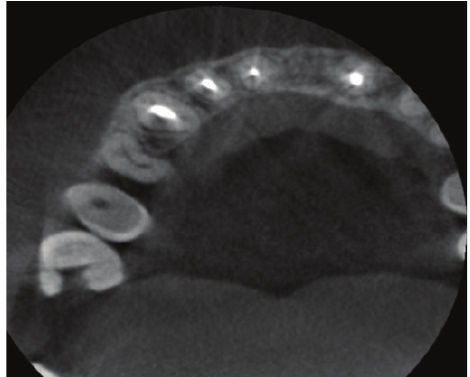
Figure 26: 1-year followup CBCT image in axial plane showing establishment of buccal and palatal cortical